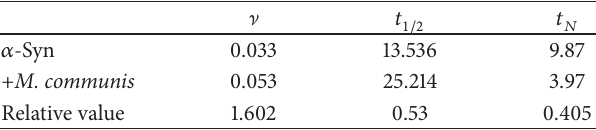
The relative values are represented as relative to values in the absence of M. communis : relative growth rate ( ] / ] control), relative half-time ( 𝑡 1/2 /𝑡 1/2 control), and relative lag time ( 𝑡 𝑁 /𝑡 𝑁